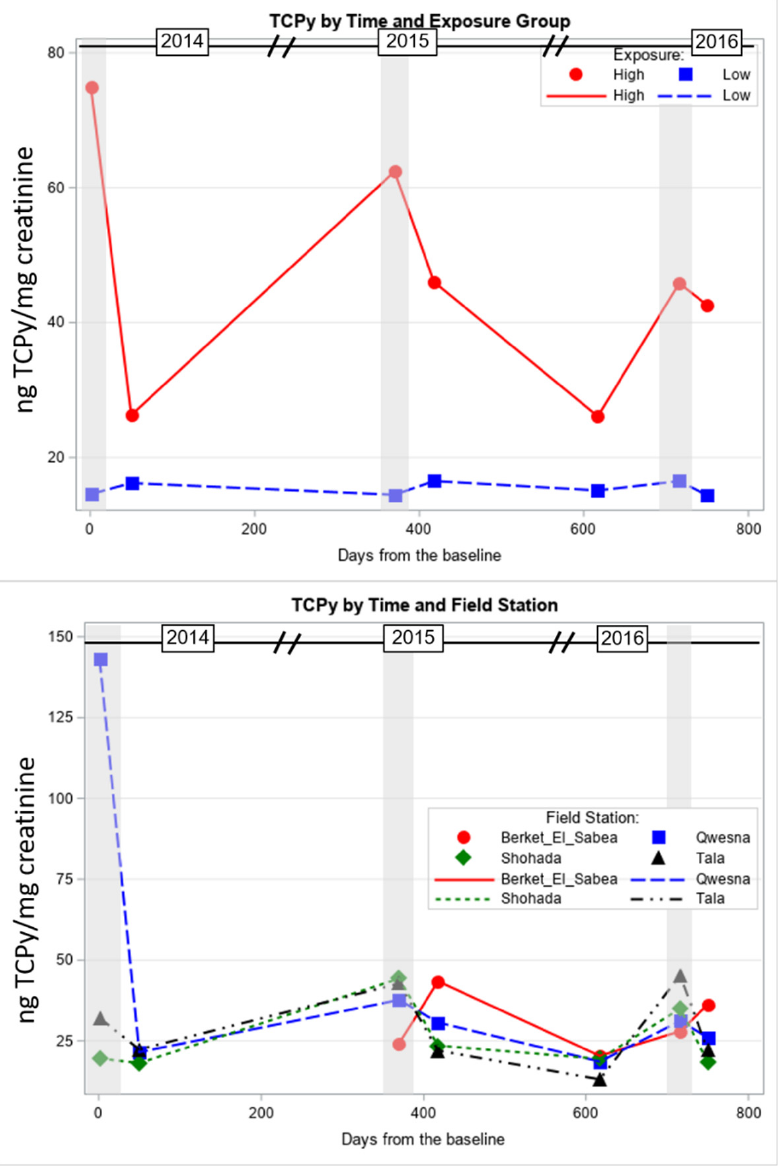
Figure 2. Urinary TCPy levels (least squares mean) in the study participants, stratified by high and low CPF exposure groups and field stations. Shaded areas indicate the times of CPF application.